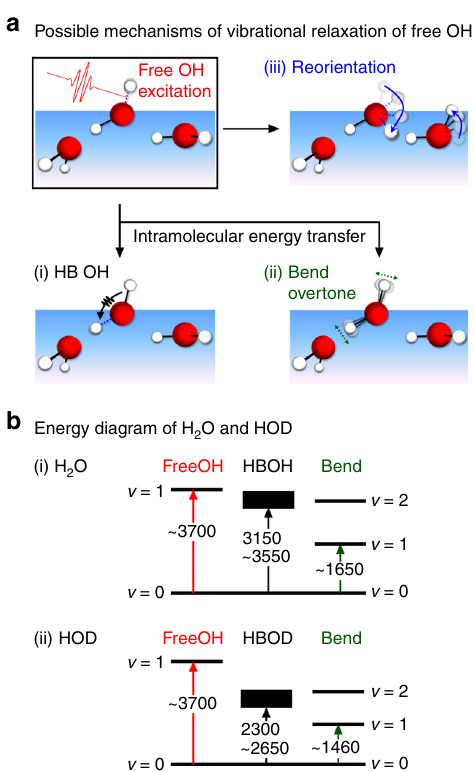
Fig. 4 Possible relaxation mechanisms of the free OH and vibrational energy diagrams of interfacial water. a Three possible relaxation pathways for the vibrationally excited free OH. Intramolecular energy transfer from the excited free OH to (i) HB OH and (ii) bend overtone, and (iii) reorientation of the topmost water molecule. Arrows in (i), (ii), and (iii) depict the energy transfer, the bend vibration, and reorientational motion, respectively. Dotted lines represent the vibration in the excited state. b The vibrational energy levels of (i) H 2 O and (ii) HOD. The bending frequencies of H 2 O and HOD are the values of bulk water 42,43 .